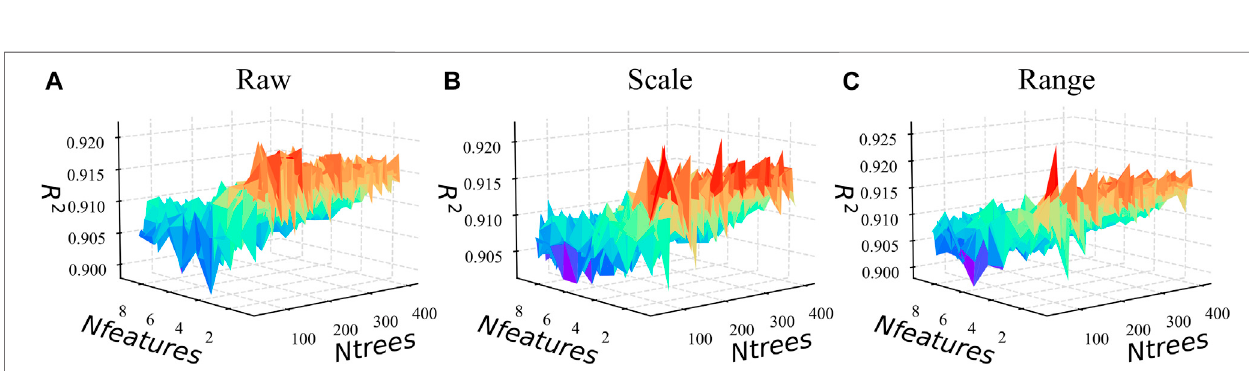
Frontiers in Energy Research |